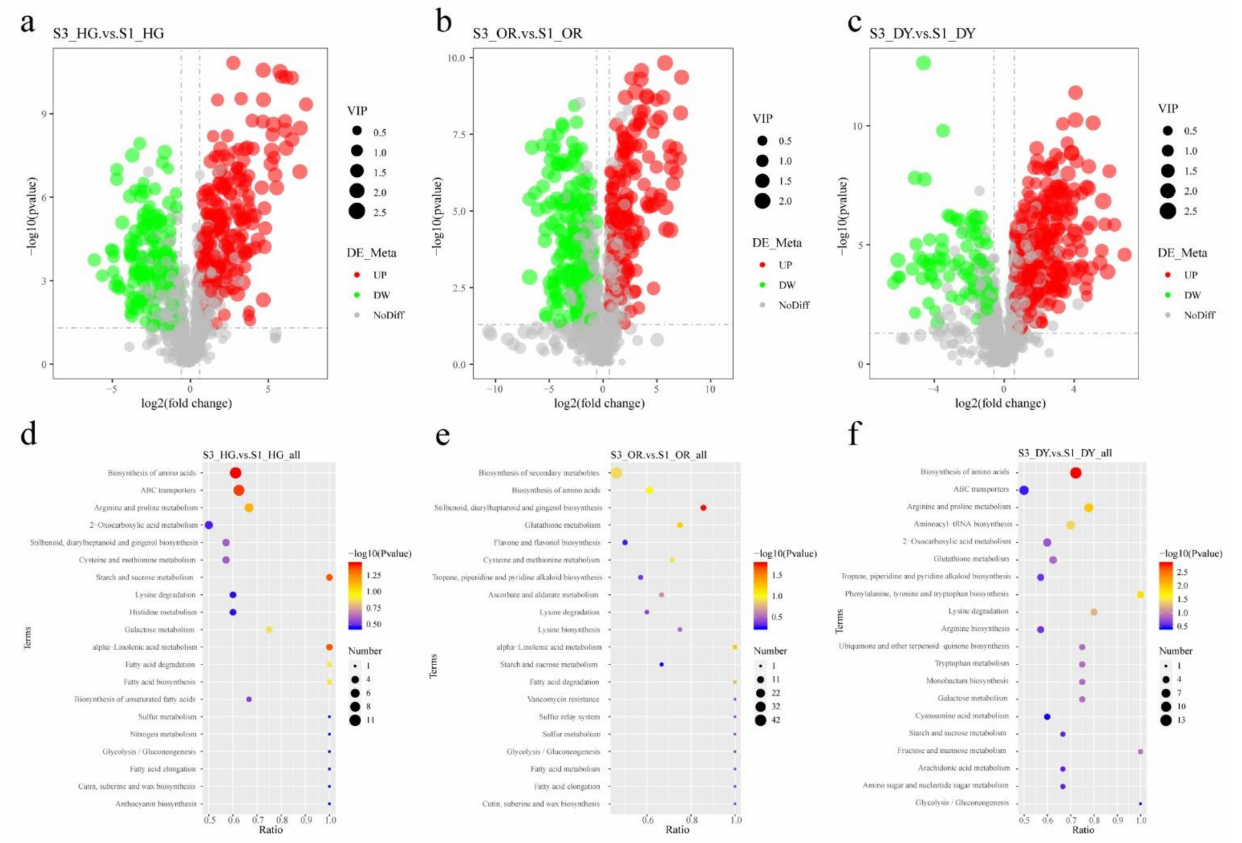
Figure 3. ( a – c ) Volcano plot of the metabolic profile at stage 3 (S3) and stage 1 (S1). The red, green and grey circles represent up-regulated, down-regulated, and non-significant metabolites, respectively. The horizontal axis represents the folded change in metabolite content, and the vertical axis represents the level of significance of the difference. Screening criteria are described in the Methods section. ( d – f ) KEGG pathway enrichment analysis of differential metabolites at S3 and S1. The horizontal coordinate of the graph is the ratio of the number of differential metabolites annotated to the KEGG pathway to the total number of differential metabolites, and the vertical coordinate is the KEGG pathway. The size of the dots represents the number of metabolites annotated to the KEGG pathway, and the color gradient from red to purple represents the significance of the size of enrichment. Sample 1 vs. Sample 2 represents the different metabolites in the former compared to the